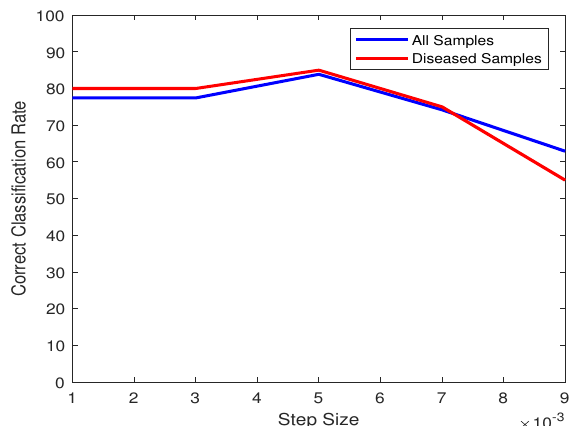
Figure 13. Plot of classification accuracies of all samples (blue) and only diseased samples (red) vs. Step